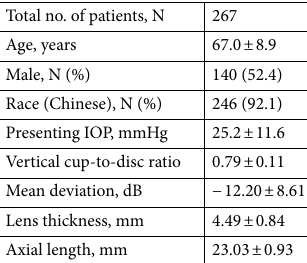
Table 1. Demographic and ocular characteristics of the subjects. IOP intraocular pressure.